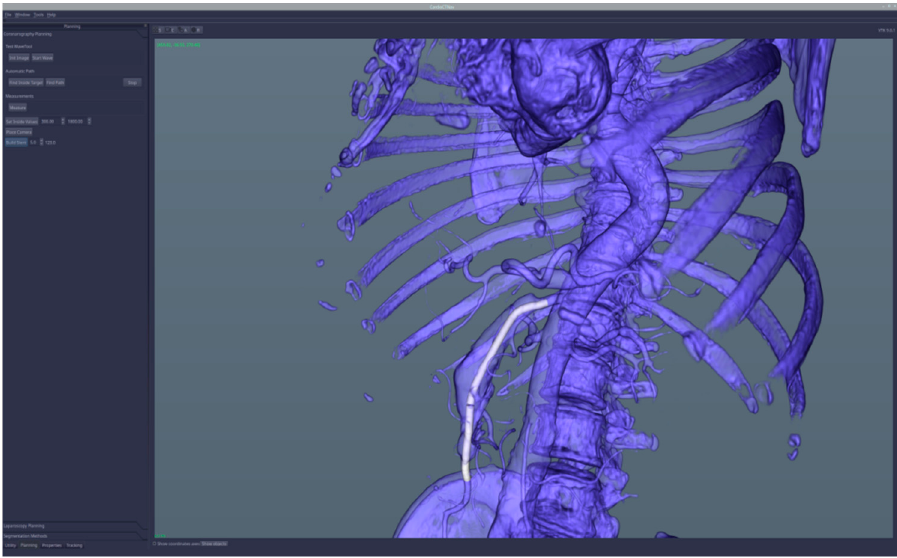
Figure 8. Measurements in the virtual 3D scene along the mesenteric artery aneurysm. Figure 3. Measurements in the virtual 3D scene along the mesenteric artery aneurysm. Table 1. Automated measurements along the aneurysm, opposite the direction of the blood flow, starting and ending with “healthy” zones.